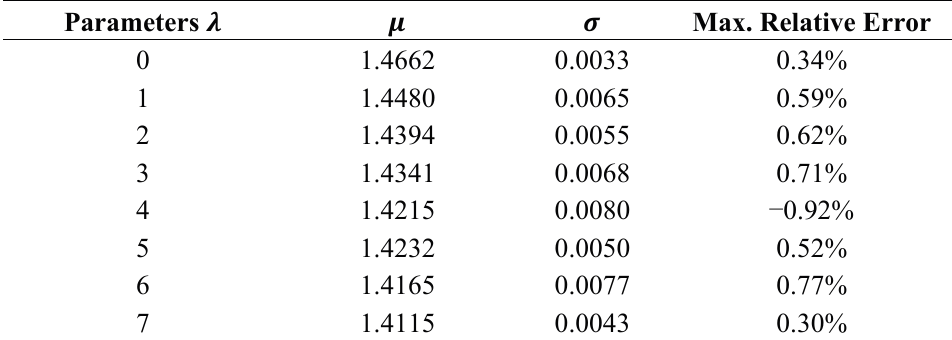
Table 3. The calculated ICR coefficient (cid:2031) for various (cid:2019) .